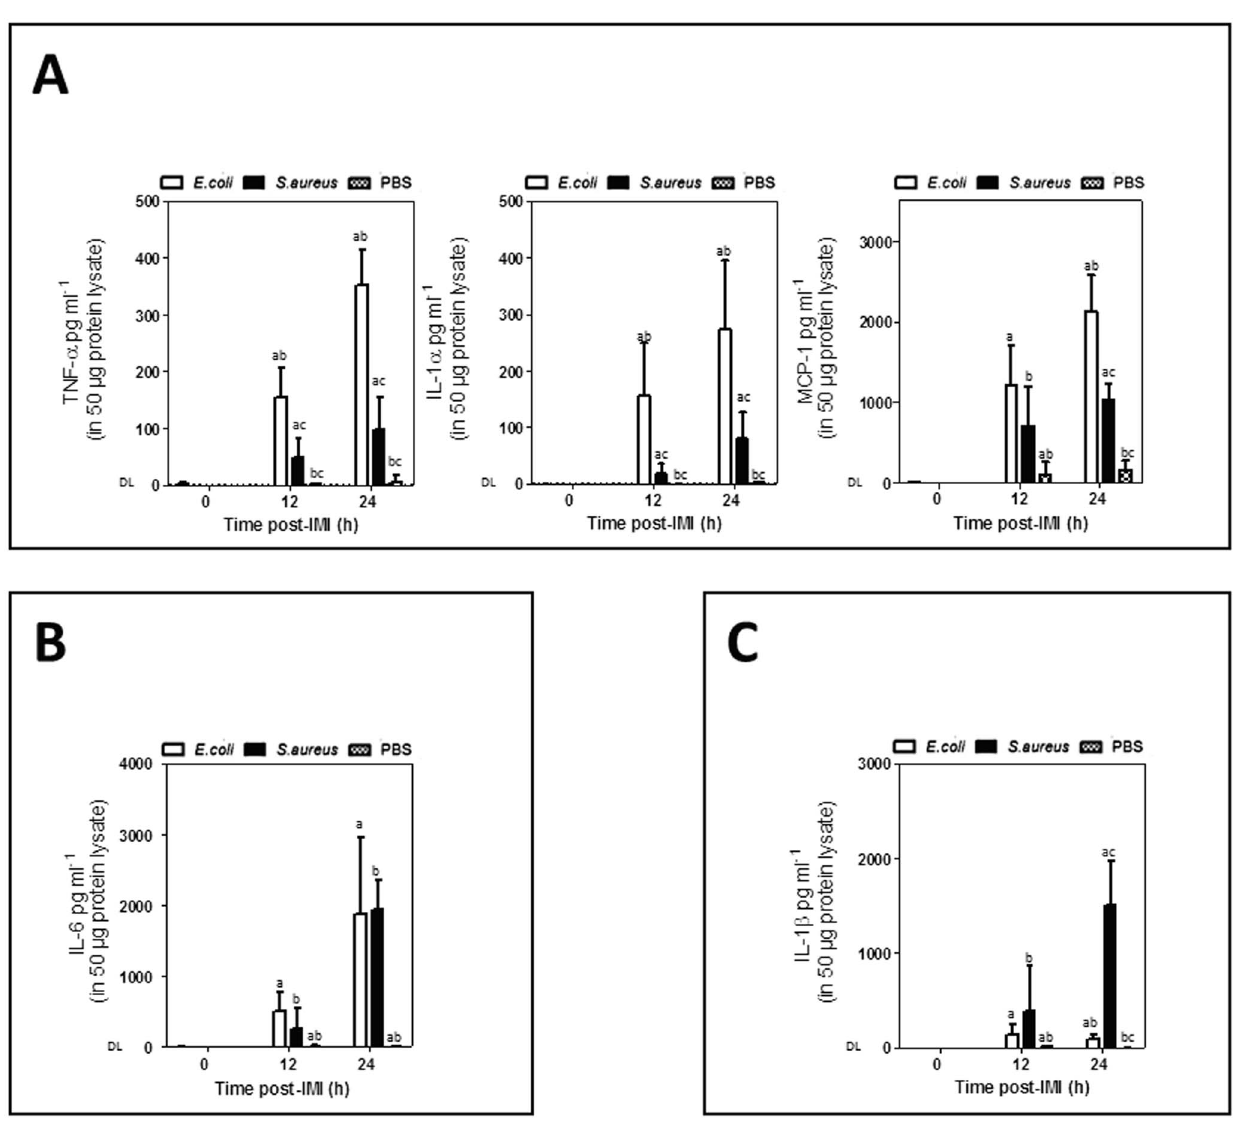
Figure 2. Differential mammary innate immune response post-IMI with E.coli versus S.aureus . (A) Local TNF-alpha, IL-1alpha, and MCP-1 concentrations in lactating mammary glands compared to mammary glands post-IMI with E. coli, S. aureus or sham-inoculated (PBS). (B) Local IL-6 concentrations in lactating mammary glands compared to mammary glands post-IMI with E. coli or S. aureus or sham-inoculated (PBS) mice. (C) Local concentrations of active IL-1beta in lactating mammary glands compared to mammary glands post-IMI with E. coli, S. aureus or sham-inoculated (PBS) mice. Letters of homogeneous subsets were marked if the difference between treatments were statistically significant (P , 0.001) (DL=detection